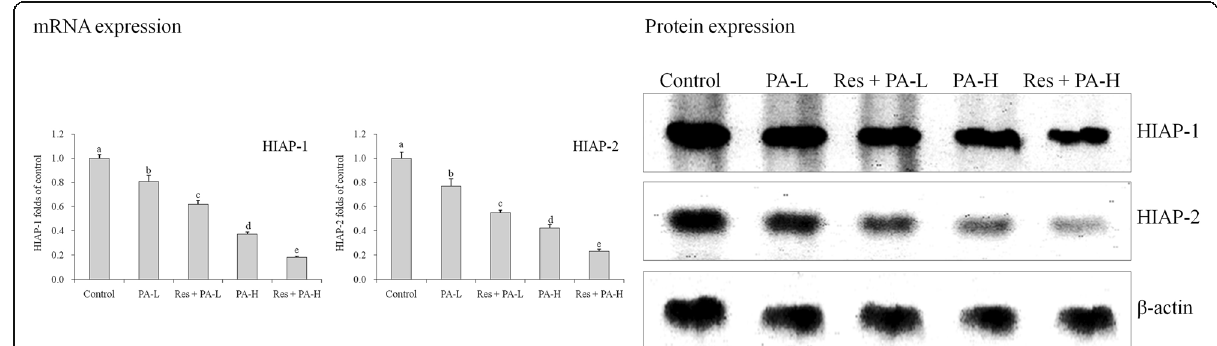
Fig. 8 The mRNA and protein expression of HIAP-1 and HIAP-2 in HepG2 human liver cancer cells. a-e Mean values with different letters over the bars are significantly different (P < 0.05) according to Dunnett ’ s post-hoc test. PA-L: 5 μ g/mL of paclitaxel; Res + PA-L: 10 μ g/mL of resveratrol